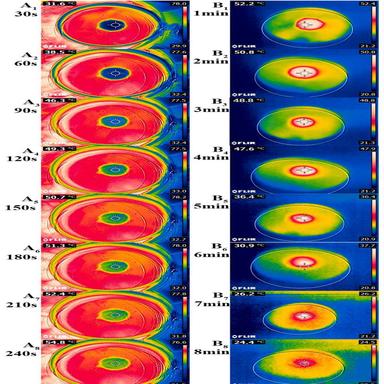
Thermal images of PS-5 during heat storage and release at different times.